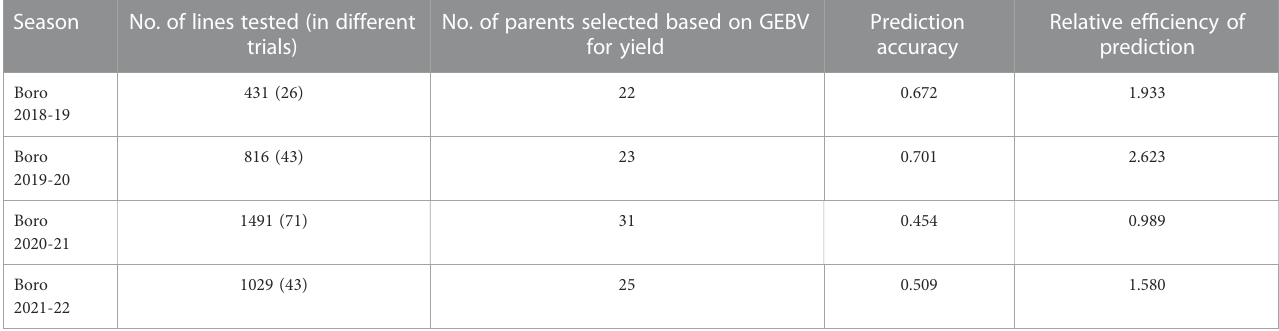
TABLE 2 Prediction accuracy and relative ef fi ciency of prediction in selecting high breeding value parents during four consecutive Boro seasons, 2018 – 19 to 2021 – 22. Season No. of lines tested (in different No. of parents selected based on GEBV Prediction Relative ef fi ciency of trials) for yield accuracy